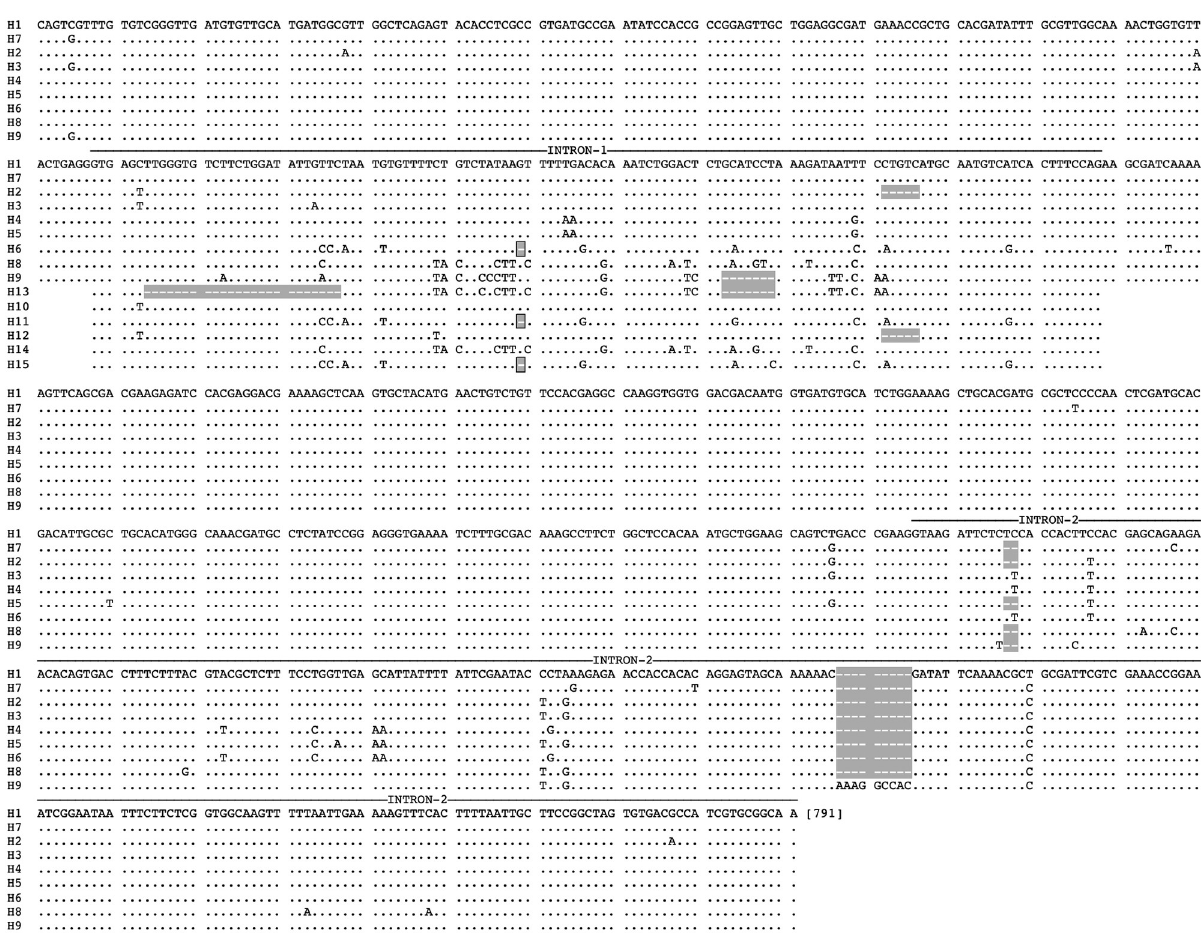
Fig 1. Sequence alignment of partial AsteObp1 haplotypes covering intron-1, identified in this study. Dots (.) represent nucleotide sequence identical to first row of sequence and dashes (‘-’) represent gap due to indel (highlighted with gey colour).